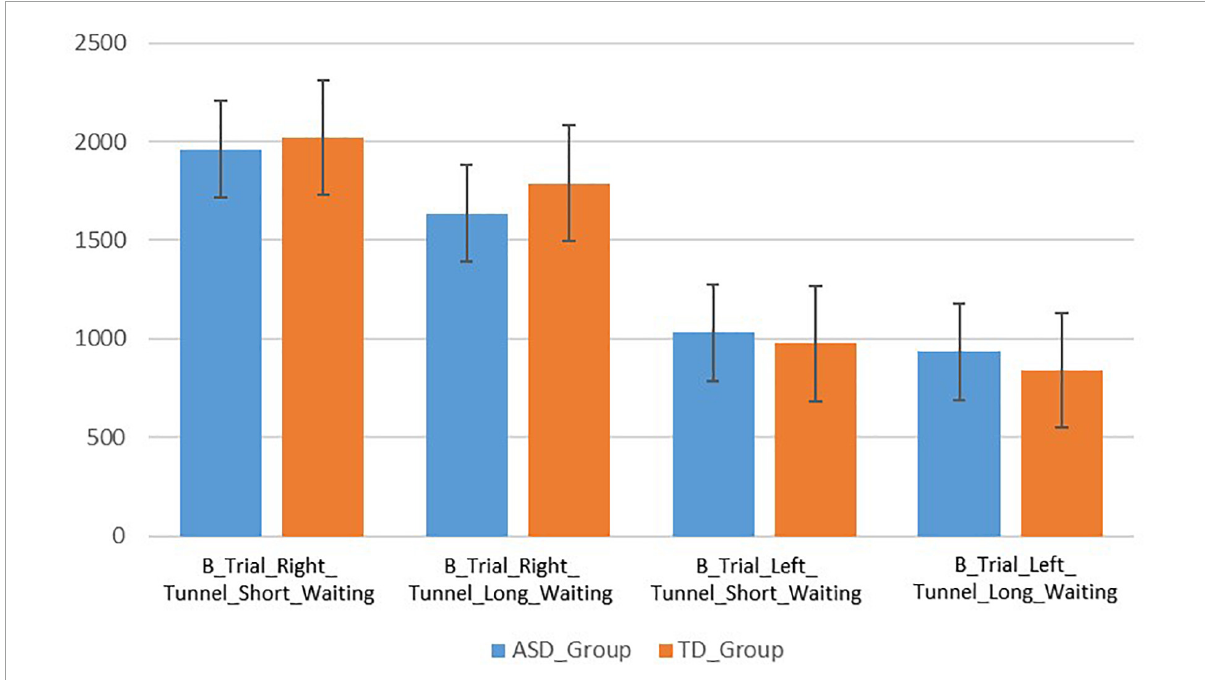
FIGURE4 Bar graph showing the looking durations at the right and left tunnels in milliseconds on B trials with short and long waiting periods for both